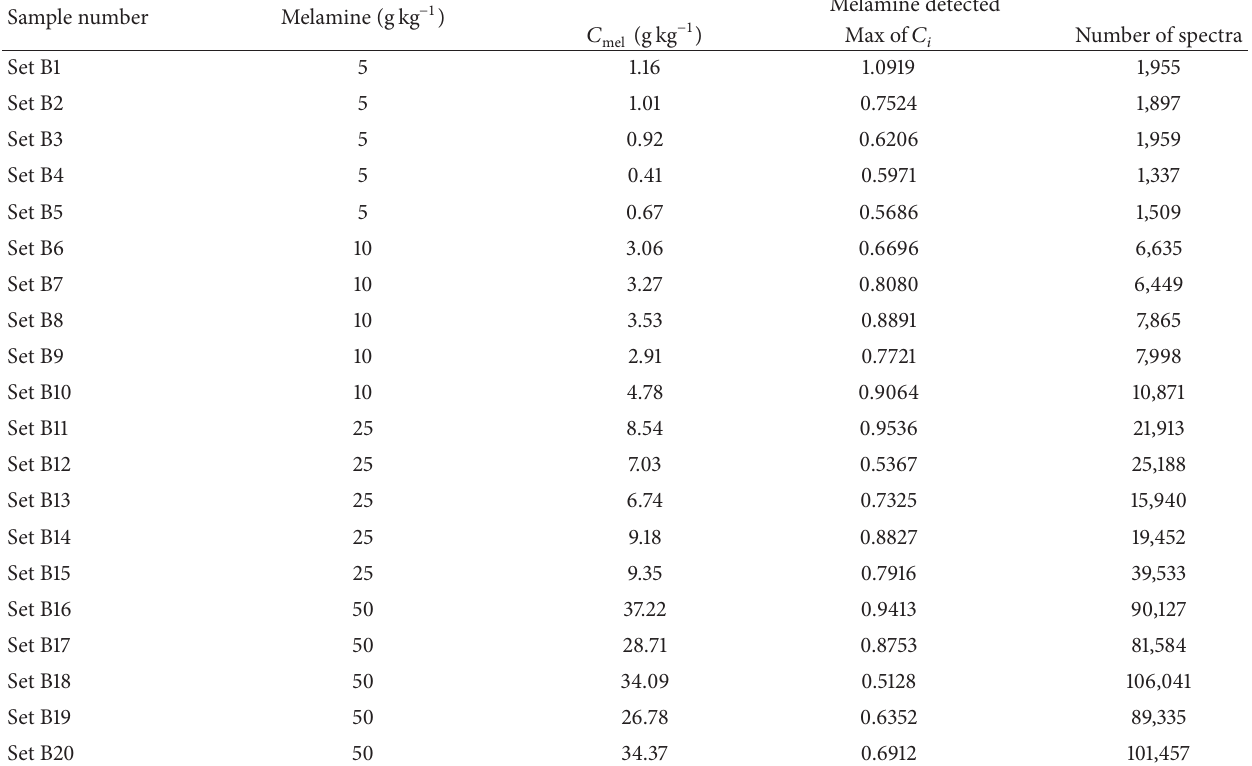
Table 3: Discriminant results of the analysis of the Set B samples using